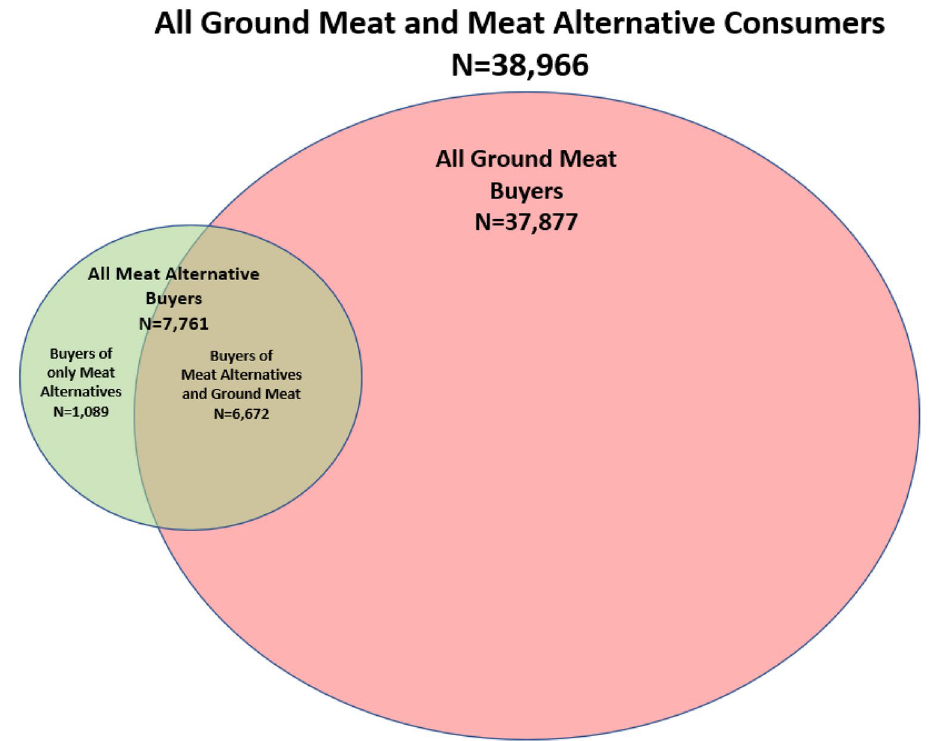
Figure 2. Overview of household consumption